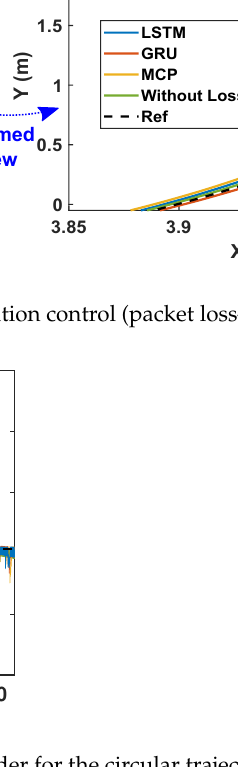
Figure 9. Distance of the follower from the leader for the circular trajectory (packet loss—30%). We repeated the circular trajectory scenario with a 50% packet loss. The follower performance is illustrated in Figure 10. LSTM again outperformed GRU and MCP in terms of prediction. The distance from the leader is depicted in Figure 11 and the MCP’s performance is compared to those of LSTM and GRU. RMSE was calculated for the X and Y positions and the heading angle of the follower in Table 3 for a 50% packet loss. Here, LSTM outperformed GRU and MCP; while packet loss was 50%, LSTM performance was only slightly worse than it was with 0% loss. Overall, LSTM performed 21.41% better than GRU and 223.17% better than MCP.